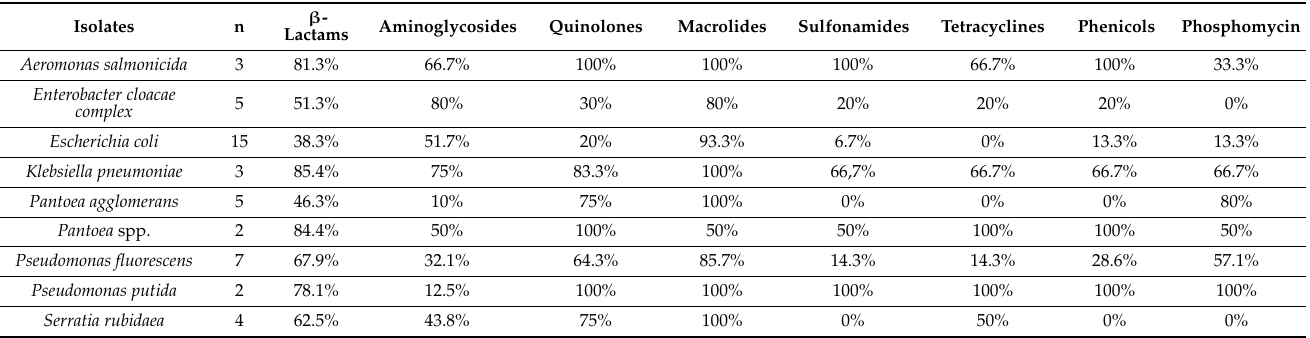
Table 1. Resistance to antimicrobial classes tested. Only bacterial species with at least two isolates are presented.